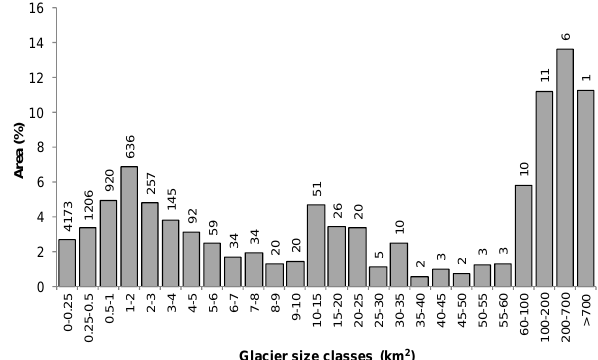
Figure 2. Distribution of glacier area over glacier size classes for the two basins combined. The numbers on top of the bins represent the number of glaciers in the particular size class.